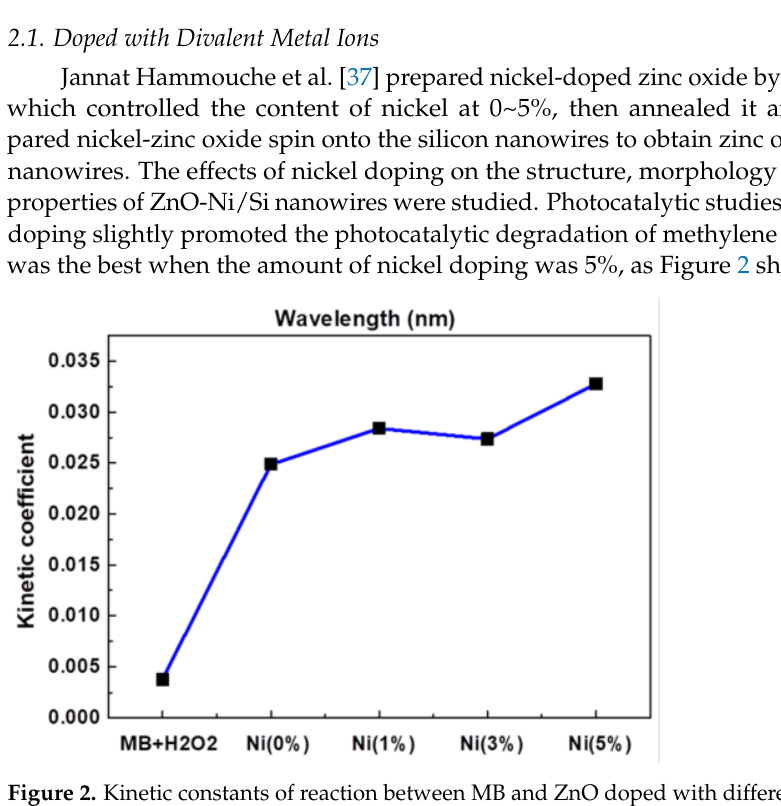
Figure 2. Kinetic constants of reaction between MB and ZnO doped with different Ni concentrations.